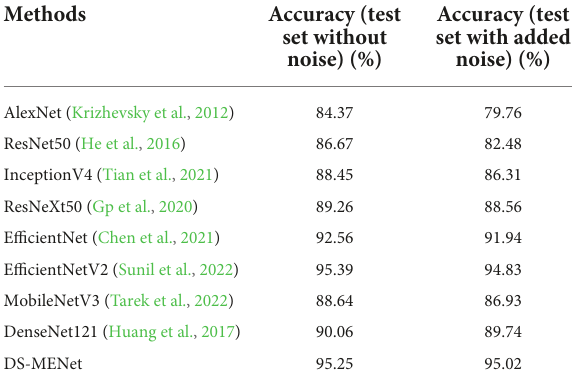
TABLE 5 Performance of DS-MENet and other network models before and after adding noise to the dataset.